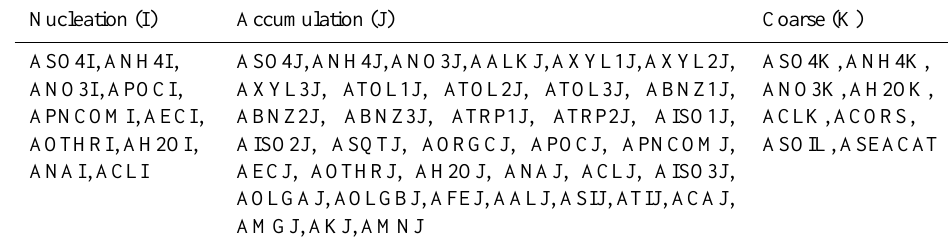
Table 2. Aerosol species for each mode in AERO6 of CMAQ ∗ (see the explanations in the text). Nucleation